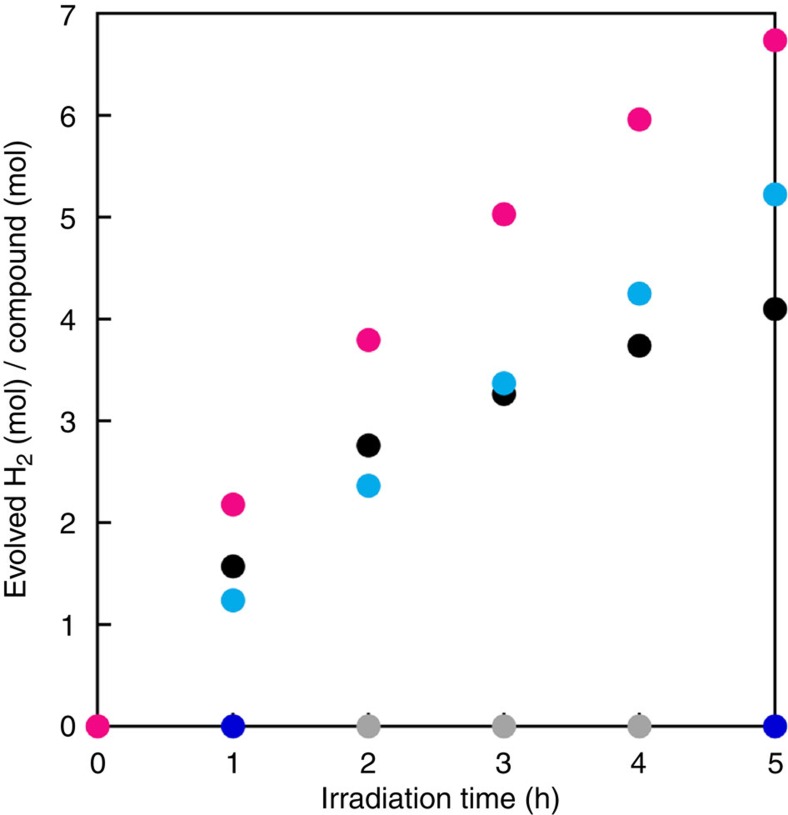
H2 evolution from MeOH solutions of apH2-based photocatalysts.Mols of evolved H2 per mols of catalyst as a function of PHER time for MeOH solutions of apH2 (2 mM; black circles), apH− (2 mM; turquoise circles), 1 (1 mM; magenta circles), and FeII(ClO4)2·6H2O (1 mM; blue circles), together with pure MeOH (grey circles). Irradiation wavelength, 289±10 nm (3.2 mW). Estimated relative s.d., 5%.